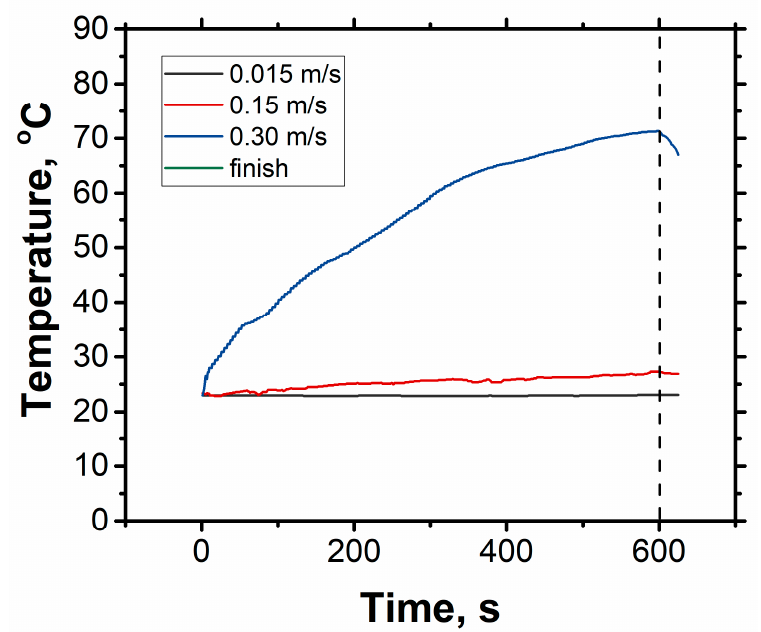
Figure 6. The change in temperature with time at sliding speeds of 0.03, 0.15, and 0.30 m/s for sample Al-2%f.s-2%Cu at a load of 20 N (0.13 MPa).